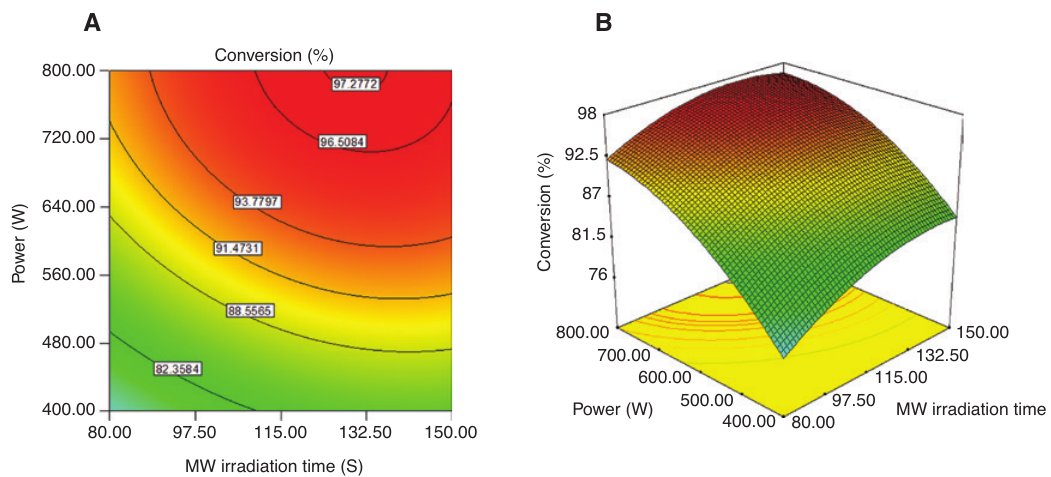
Figure 3: (A) Two-dimensional (2D) and (B) 3D interaction between MW irradiation time and power on FAME conversion.